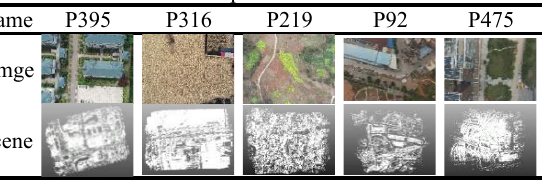
Table.1 Sample UAV images and the corresponding